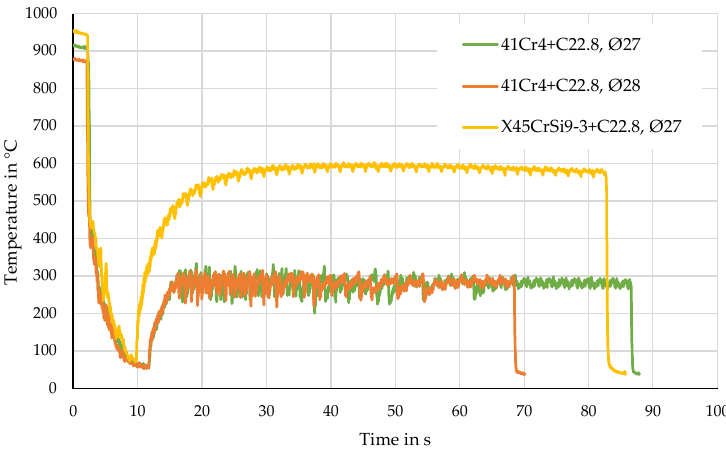
Figure 6. Temperature curves measured with a pyrometer at the tooth flank of the bevel gear.